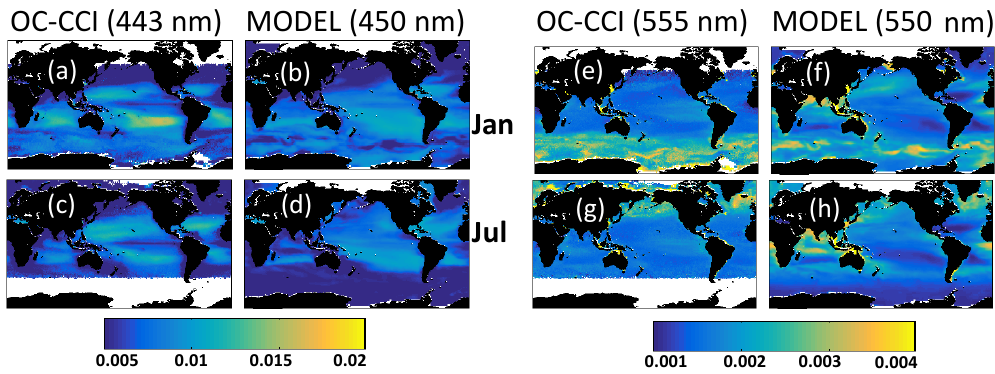
Figure 2. Remotely sensed reflectance (1/sr) for (a) OC-CCI at 443nm, January; (b) model at 450nm, January; (c) OC-CCI at 443nm, July; (d) model at 450nm, July; (e) OC-CCI at 555nm, January; (f) model at 550nm, January; (g) OC-CCI at 555nm, July; (h) model at 550nm, July. We compare the model wavebands against the nearest OC-CCI wavebands, but note that they are not identical. OC-CCI products (a, c, e, g) have no data when irradiances are too low. For the model, lack of output indicates regions where PAR is less than 15µEinm − 2 s − 1 or the unresolved Arctic region. OC-CCI products were downloaded from https://www.oceancolour.org.